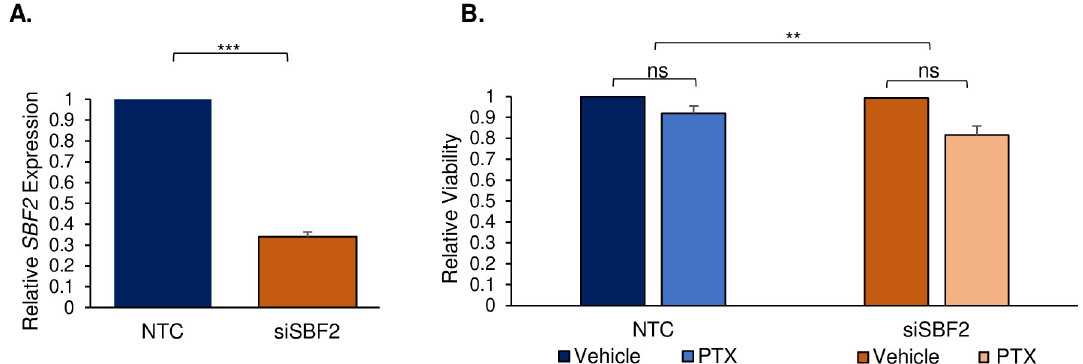
Fig 2. Silencing SBF2 in iPSC-dSN exacerbates paclitaxel-induced viability phenotype. A) Relative expression of SBF2 in si SBF2 cells relative to NTC cells. B) Viability of paclitaxel-treated NTC and si SBF2 cells relative to baseline (vehicle-treated cells). Graphs represent all six cell lines compiled and performed in triplicates. (NTC = non-targeted control, PTX = paclitaxel, ns = non-significant, �� = p < 0.01, ��� = p < 0.001). Error bars represent SEM.